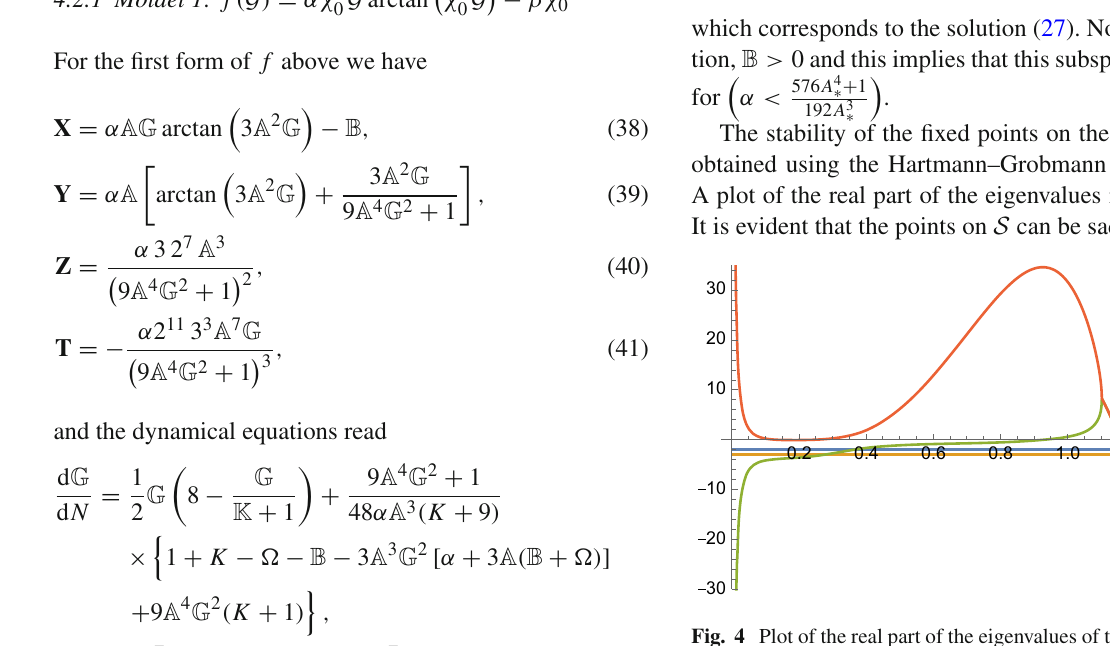
Fig. 4 Plot of the real part of the eigenvalues of the fixed points of the line L for f ( G ) = αχ 2 to be 3 and w =